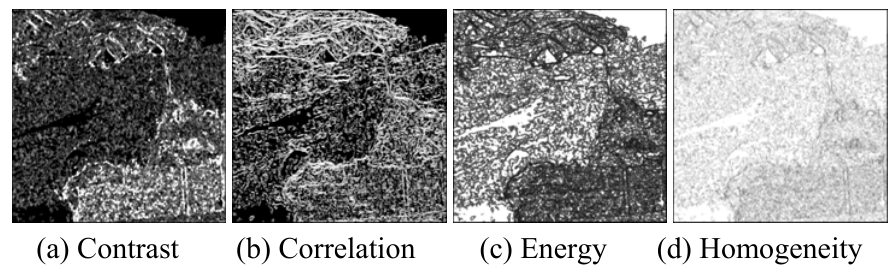
Figure 8. GLCM-based features of T